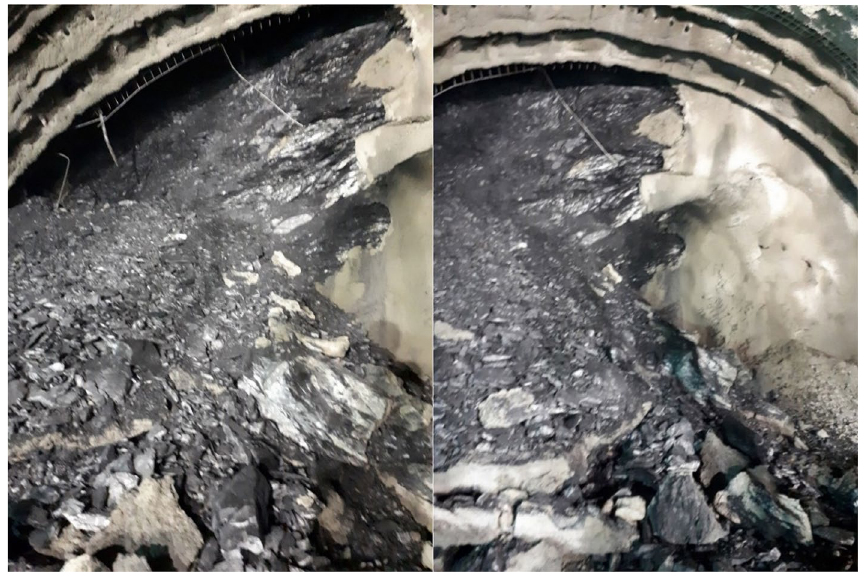
Figure 6. Tunnel face excavation view in the graphitic schist.